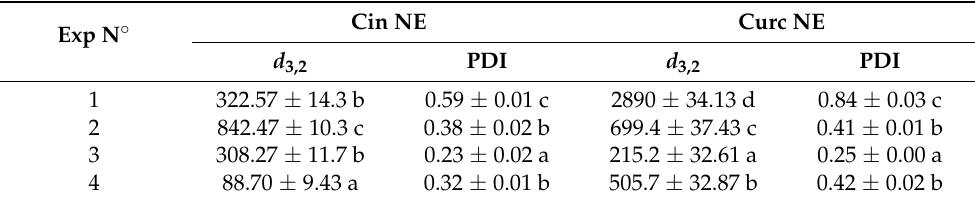
Table 3. Cinnamon (Cin) and curcuma (Curc) nanoemulsion formulation characteristics: d 3,2 —average droplet size expressed in nm; PDI—polydispersity index.